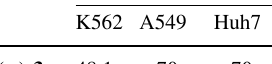
induced Smad2/3 phosphorylation in NRK-52e cells. NRK-52e cells were treated with TGF- β 1 (10 ng/mL) for 1 h in the absence or pres- ence of different concentrations of the compounds. Cell lysates were immunoblotted with antibodies against p-Smad3, Smad3, p-Smad2, Smad2, and GAPDH Table 4 Cytotoxicity against Groups IC 50 (μM) three different human cancer cell lines